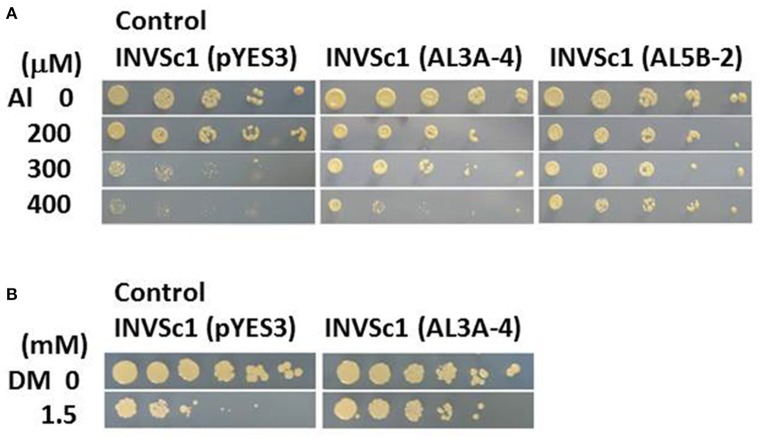
Sensitivity test of the yeast TF carrying AL3A-4 or AL5B-2 clones on agar plates. (A) Al test on LPM agar plate (adjusted at pH4.2), (B) DM test on YNB agar plate (adjusted at pH5.7). Log phase cells of the TFs carrying either pYES3 (vector), AL3A-4 or AL5B-2 were serially diluted with sterilized water(1/5~1/3125 fold for Al test and 1~1/3125 fold for DM test) and then spotted on the agar plates. Plates were incubated at 30°C for 3 to 4 days and the sensitivity was estimated by a colony forming ability on the agar plates.